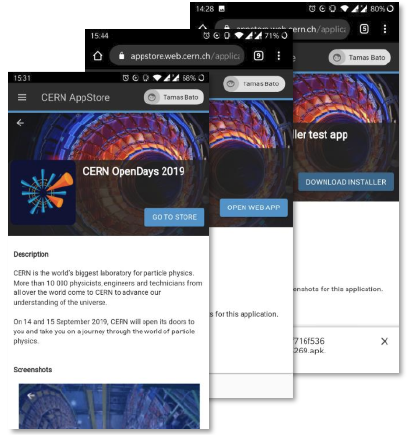
Figure 3. Store views on mobile